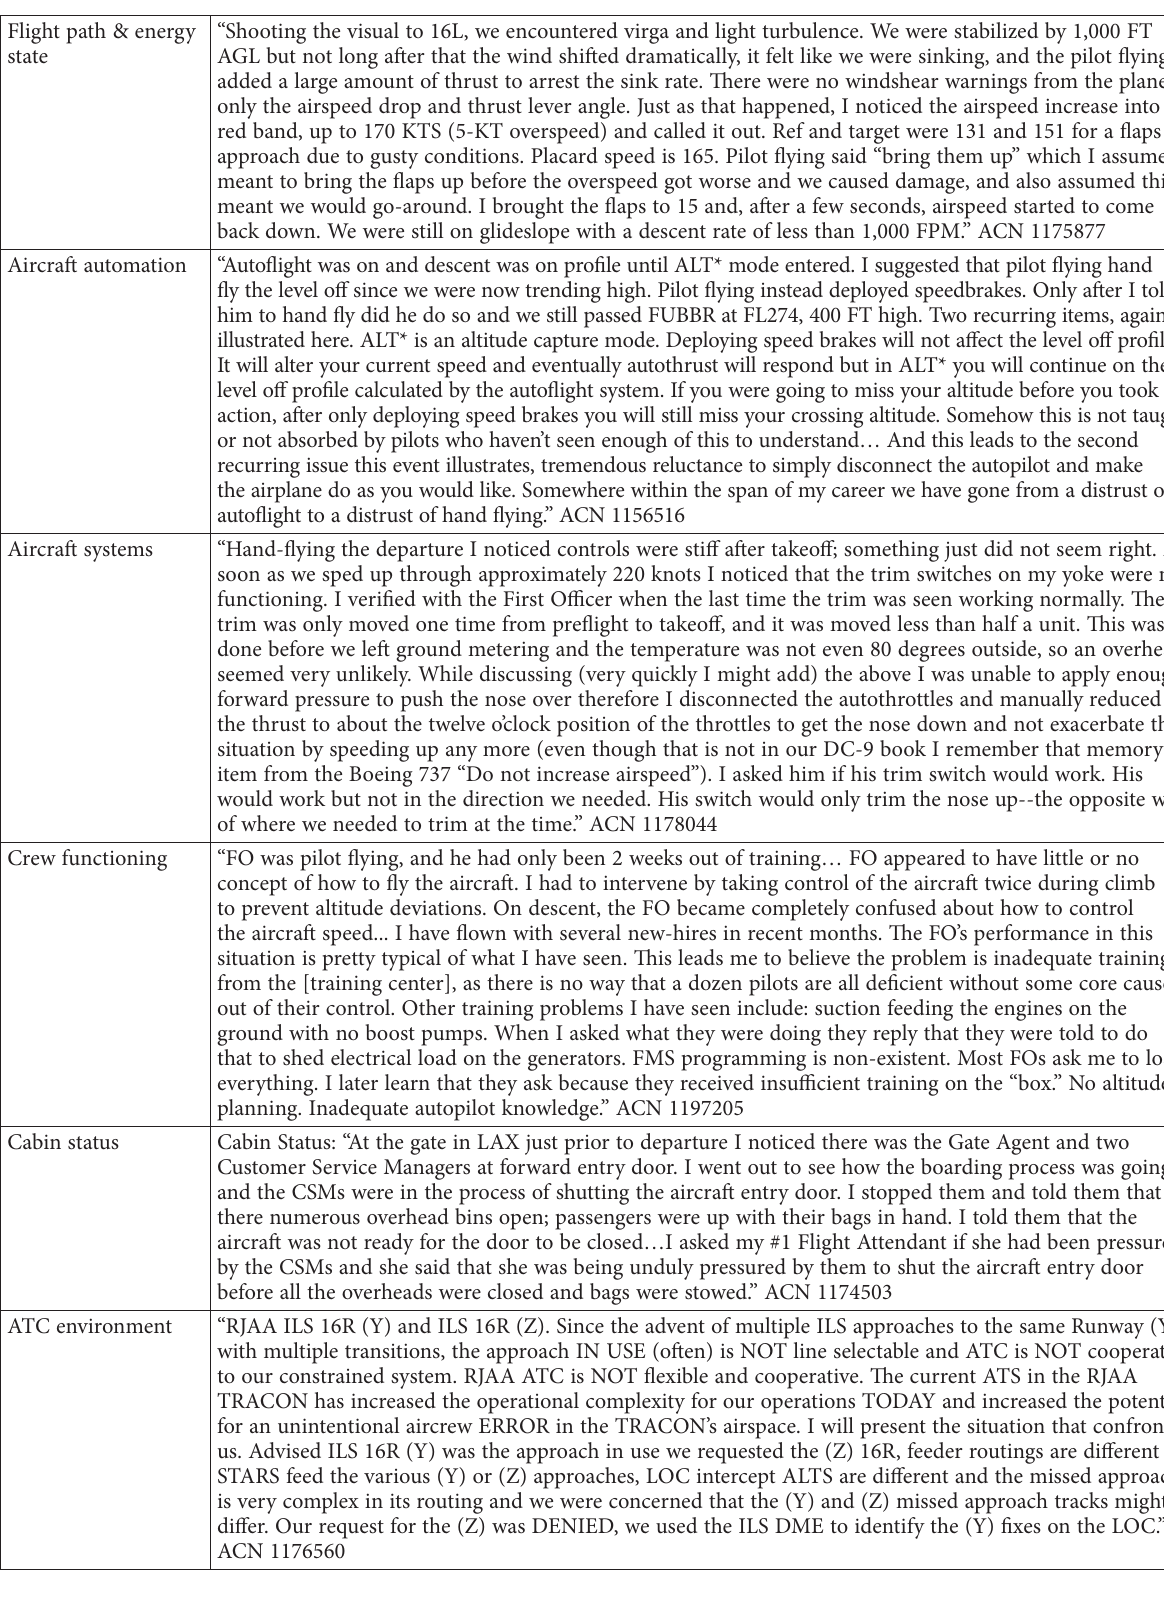
Table 3. Example narrative content for each situation awareness category Flight path & energy